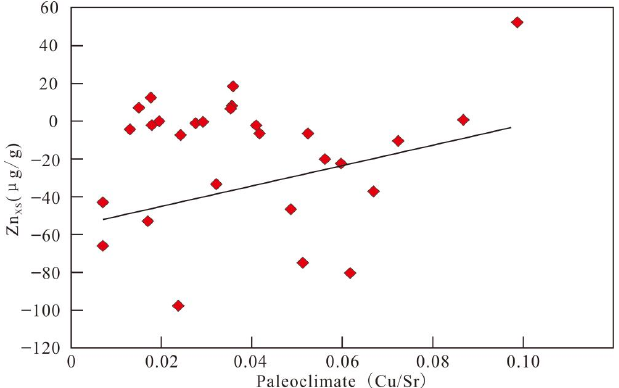
Figure 19. The relationship between the paleoproductivity and paleoclimate in the West Lishui Sag.